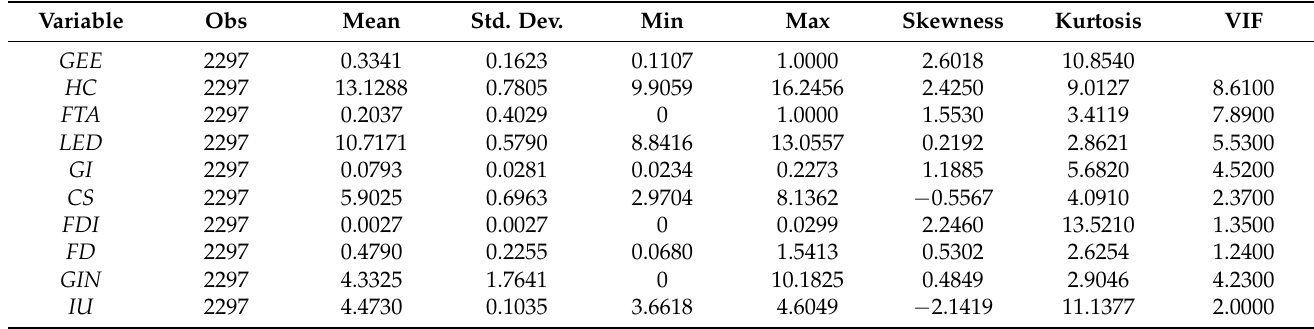
Table 2. The statistics summary of